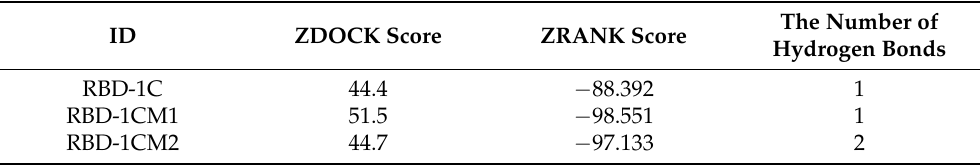
Figure 1. Best docking pose of RBD-1C aptamer against the S protein (visualization software: DS 4.1). Amino acids and nucleotides involved in the binding interface of the S protein/RBD-1C complex are marked with yellow. The close-up view presents the amino acids and nucleotides in the binding interface marked by labels. Table 1. Docking results of RBD-1C, RBD-1CM1, and RBD-1CM2 aptamer against the S protein. The number of hydrogen bonds in the interface of the best docking pose of the complex was predicted by using the VMD software.